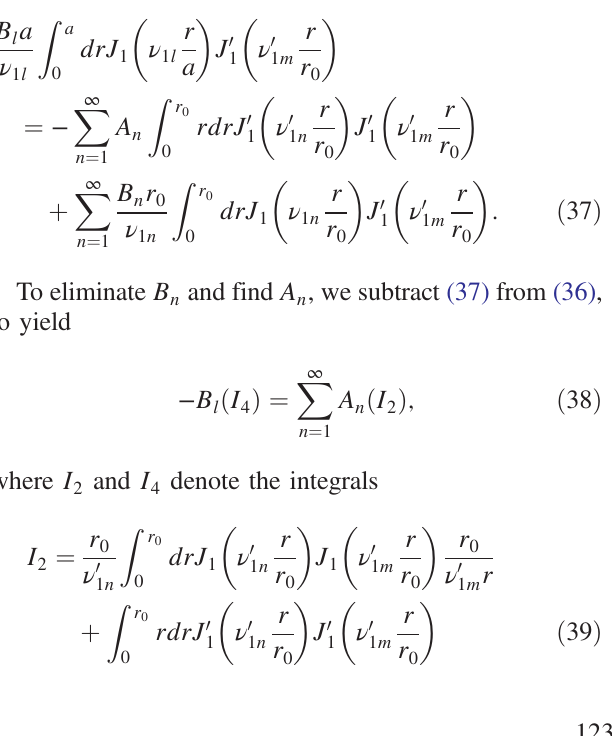
and Eq. (29) for E ϕ , with the r Þ ; B n n